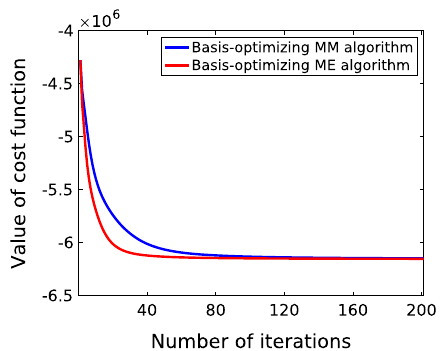
Fig. 4 Behavior of the cost functions (12) except for the constant term under the babble noise condition in the proposed basis-optimizing RCSCMEs. The cost functions are averaged over 10 parameter-initialization random seeds. The shape parameter ρ in GGD is set to